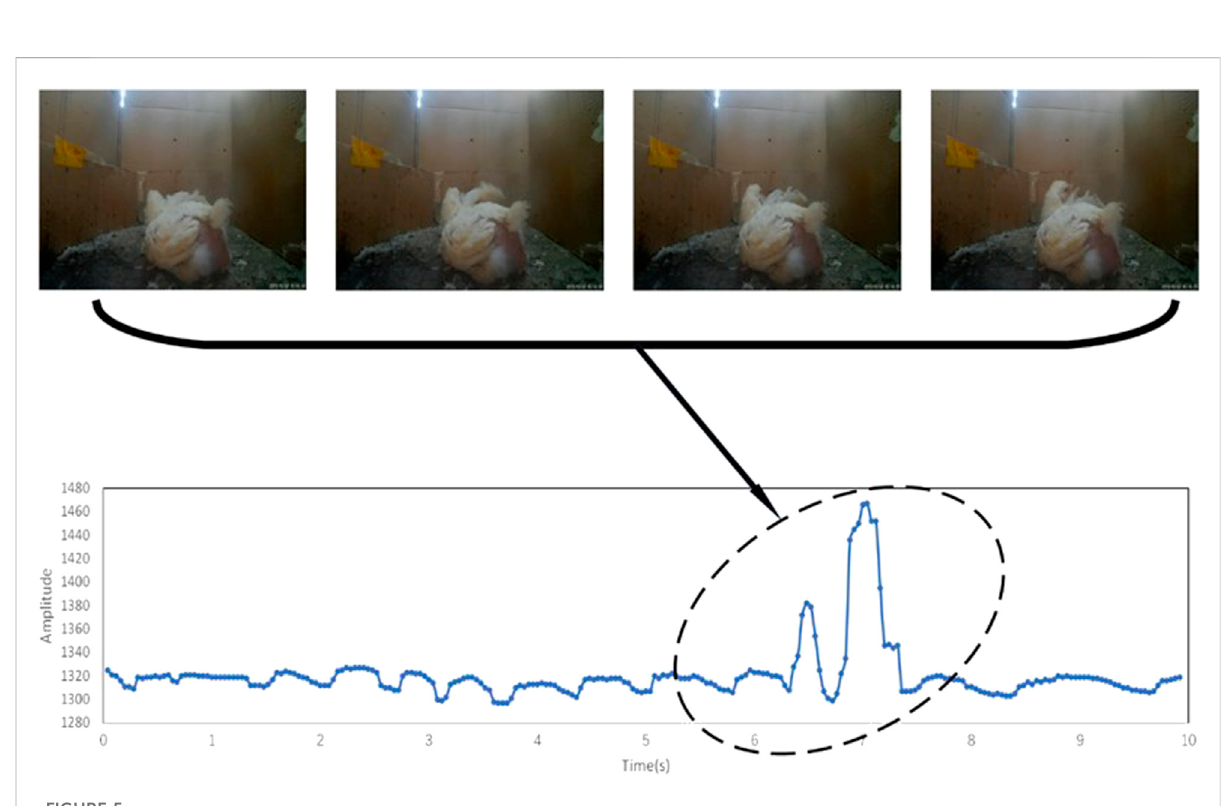
FIGURE 5 Centroid Y signal changes due to broiler